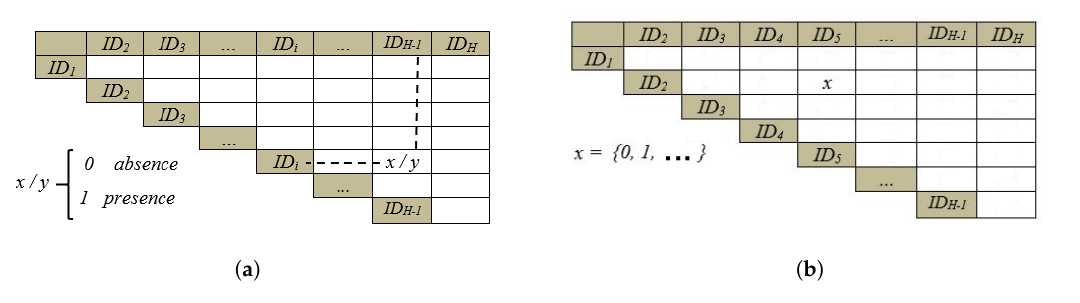
Figure 2. Structure of the WD matrices: a) A k co − prs , b) C k co − prs